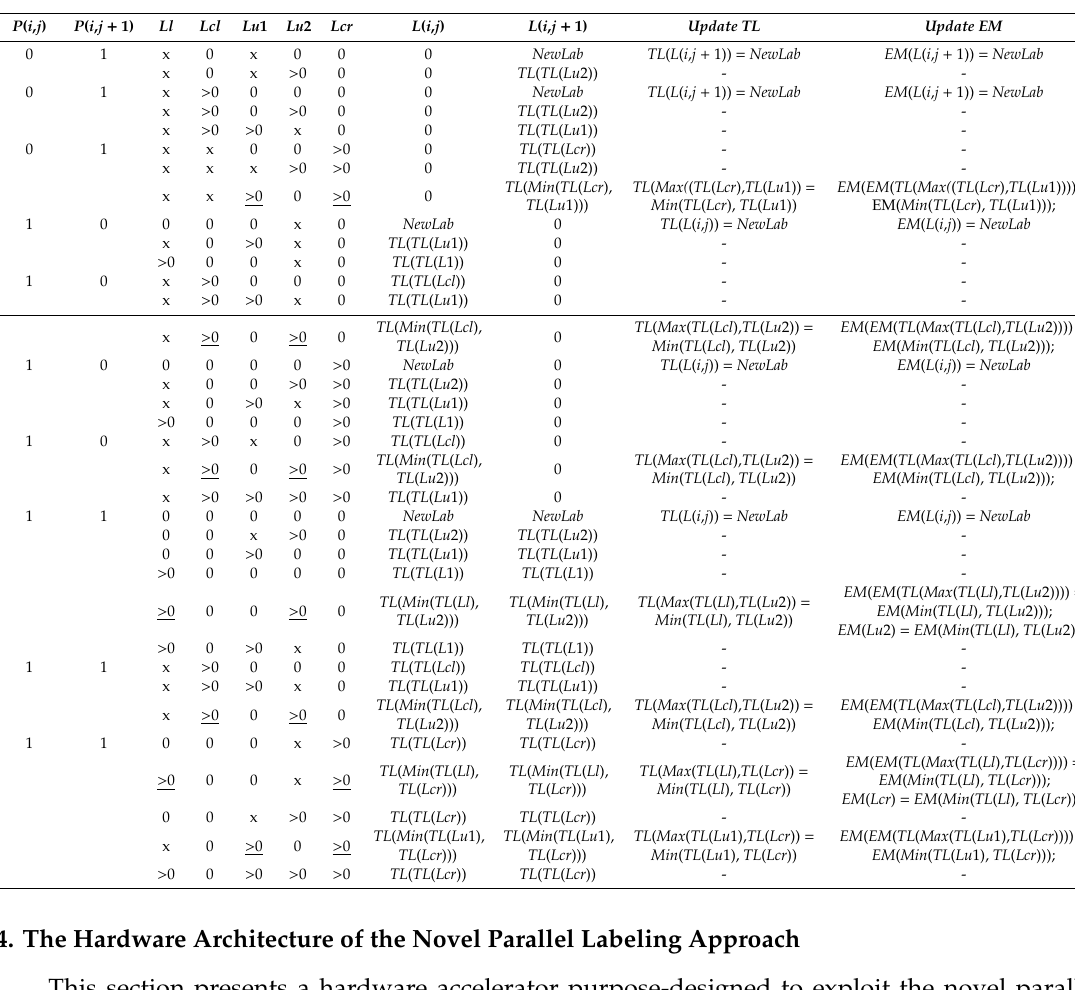
Table 2. Rules to apply to 8-connected neighbourhoods for labelling two adjacent pixels in parallel.